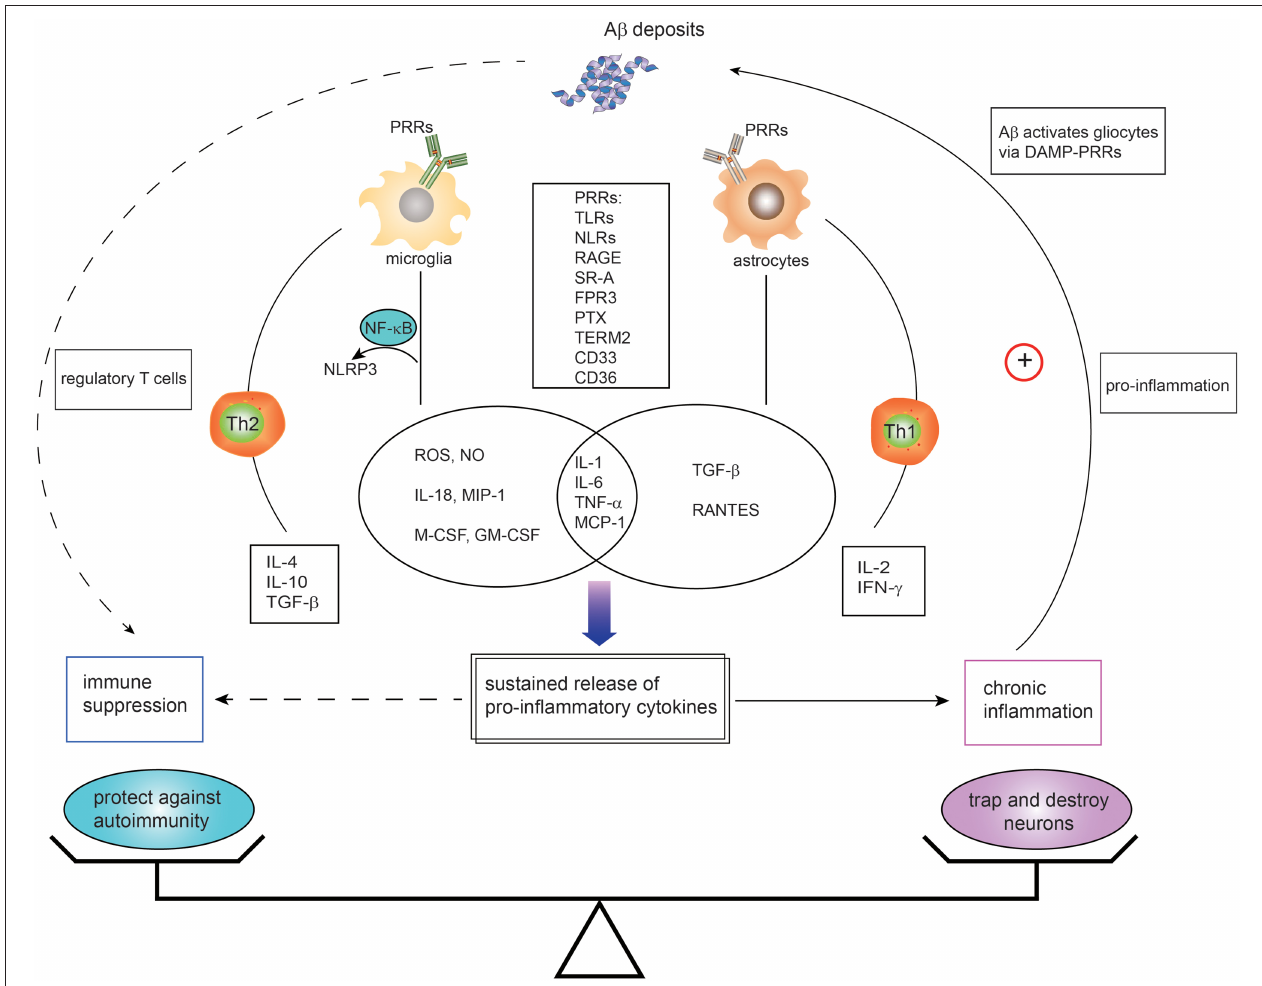
FIGURE 1 | Dual immunomodulation of brain amyloid β deposits in the context of Alzheimer’s disease. Microglia and astrocytes, expressing innate immune receptors—pattern recognition receptors (PRRs)—can be activated in response to amyloid- β (A β ) via DAMPs-PRRs ligation. Such PRRs include toll-like receptors (TLRs), nucleotide-binding oligomerization domain-like receptors (NLRs), receptor for advanced glycation end products (RAGE), scavenger receptors (SRs), N-formyl peptide receptors (FPRs), pentraxin (PTX), triggering receptor expressed by myeloid cells 2 (TREM2), CD36, and CD33. The activation of microglia and astrocytes leads to secretion of proinflammatory cytokines and chemokines. Activated microglia with TLRs agonist or cytokines also activate NALP3 inflammasomes via nuclear factor kappa B (NF- κ B) mediated signaling, resulting in production of proinflammatory mediators. While the proinflammatory cytokines derived from activated cells initially account for the phagocytosis of A β deposition, the self-sustaining proinflammatory mediators and chronic inflammation contribute to the malfunction and death of neurons and eventually leads to AD development. Likewise, the chronic neuroinflammation in turn hastens cycle reinforcing A β deposition. In addition, Th1 cells and Th2-polarized cells are activated with implication in proinflammatory and anti-inflammatory regulation. However, direct and indirect evidence is emerging that A β has immune suppressive activity and protects against autoimmune disorders. It is likely that the states and activities of brain A β might be orchestrated by a whole variety of different factors. TNF, tumor necrosis factor; TGF, transforming growth factor; IFN, interferon; DAMPs, damage-associated molecular patterns; TREM2, triggering receptor expressed by myeloid cells 2; IL, interleukin. G-CSF, granulocyte colony-stimulating factor; GM-CSF, granulocyte macrophage colony-stimulating factor; IFN- γ , interferon-gamma; M-CSF, macrophage colony stimulating factor; NLRP3, NOD-like receptor, type 3; NO, nitric oxide; ROS, reactive oxygen species; SRs, scavenger receptors; TLRs, Toll-like receptors; MIP-1, macrophage inflammatory protein 1; MCP-1, monocyte chemoattractant protein-1; RANTES, regulated